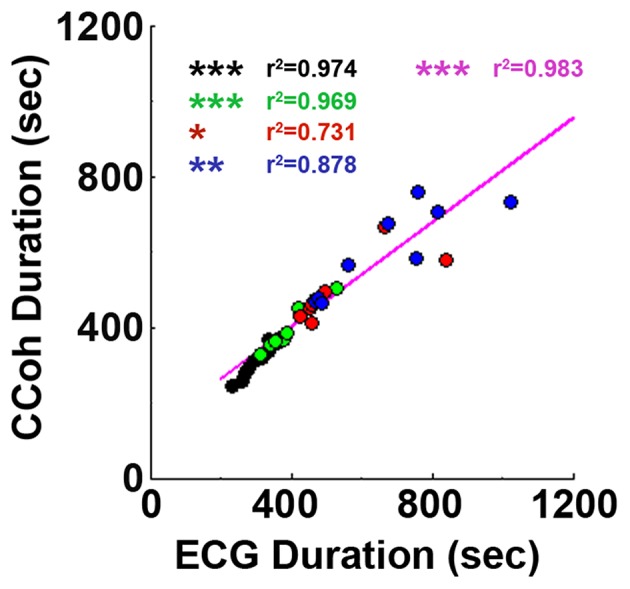
Cardiac survival parallels with cortical coherence (CCoh) duration. Each circle represents data from one rat. Linear regression line was plotted to show the correlation between ECG signal duration and CCoh duration for all four groups of rats. Significant correlations between ECG signal duration and CCoh duration are indicated using asterisks. Different color circles represent different treatment groups: saline control in black, phentolamine in green, atenolol in red and phentolamine plus atenolol in blue. The magenta color represents values obtained with all four groups of rats (n = 35). (*p < 0.05, **p < 0.01, ***p < 0.001).